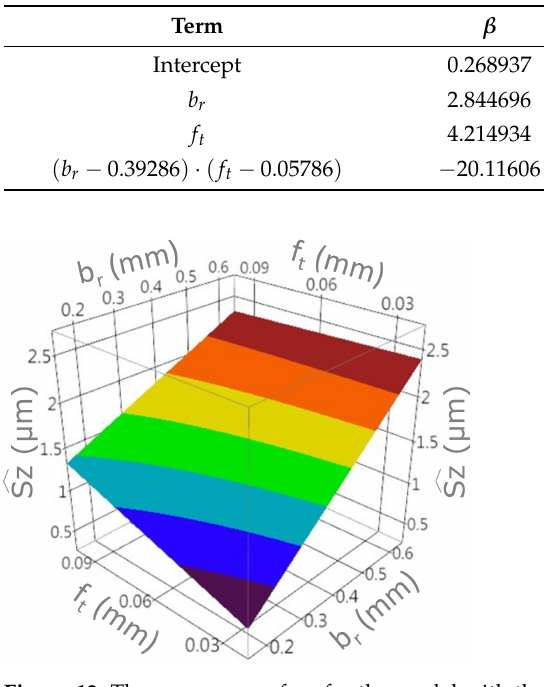
Table 4. Equation coefficients for raw data β and standardized data Std β as well as the results of the t test for the coefficients of the regression equation for the (cid:98) Sz parameter.